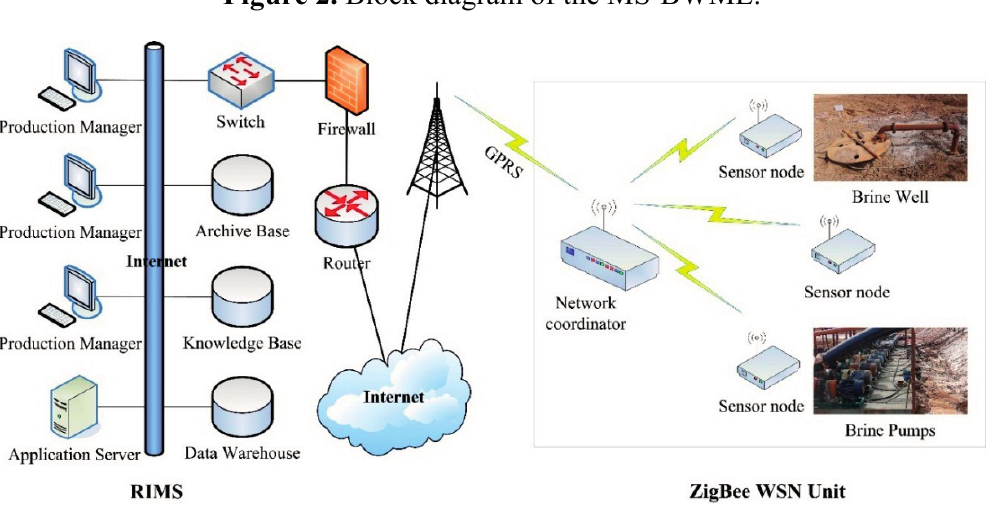
Figure 2. Block diagram of the